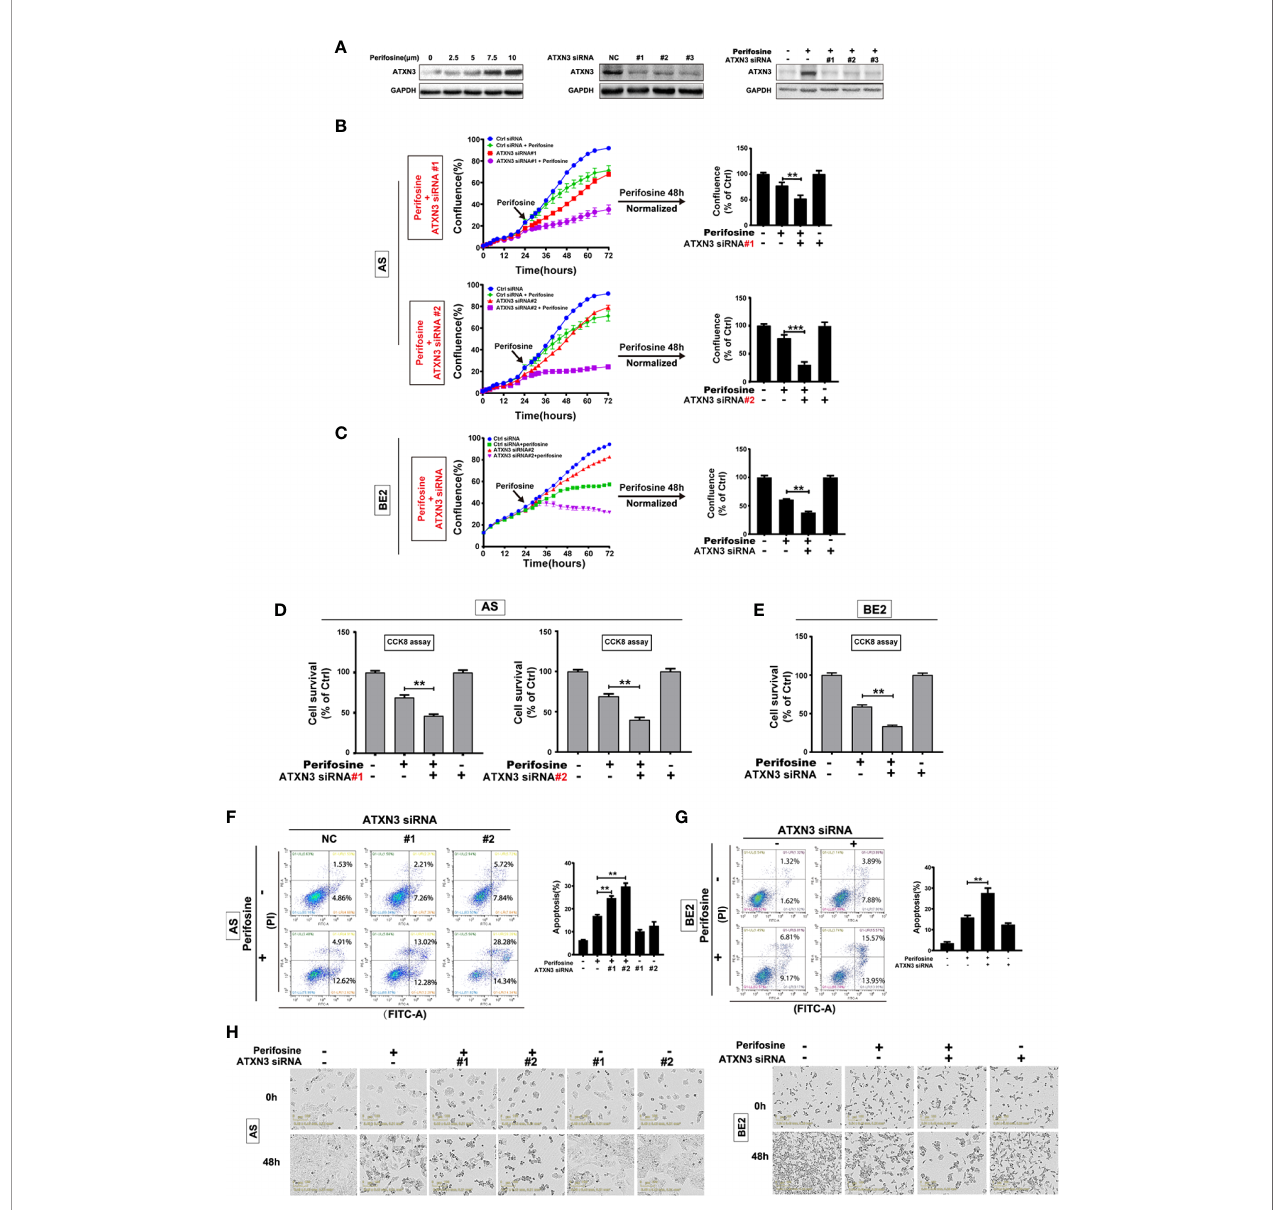
FIGURE 1 | Downregulation of ATXN3 promoted perifosine-induced cell death in NB cells. AS cells were treated with different concentrations of perifosine (2.5, 5, 7.5, and 10 m M) for 24 h, or transfected with ATXN3 siRNA (#1, #2, #3, and control) for 48 h, or transfected with ATXN3 siRNA (#1, #2, and #3) for 16 h followed by 24 h treatment of perifosine. (A) The expression of ATXN3 were detected by Western blot; (B, C) AS cells were transfected with ATXN3 siRNAs (#1, #2), and BE2 cells were transfected with ATXN3 siRNA2 (marked as ATXN3 siRNA) for 16 h, followed by 48 h treatment of perifosine: Cell con fl uence was dynamically detected by IncuCyte Zoom and analyzed at the end of experiment; (D, E) Cell survival was detected by CCK8 assay; (F, G) cell apoptosis was detected by Annexin V/PI fl ow cytometry; (H) The images of AS and BE2 cells with ATXN3 siRNAs transfection and perifosine treatment at 0 h and 48 h were recorded. Bar, SD, **P < 0.01, ATXN3 siRNAs + perifosine vs. control siRNA + perifosine; ***P < 0.001, ATXN3 siRNA #2 + perfosine vs. control siRNA + perifosine.